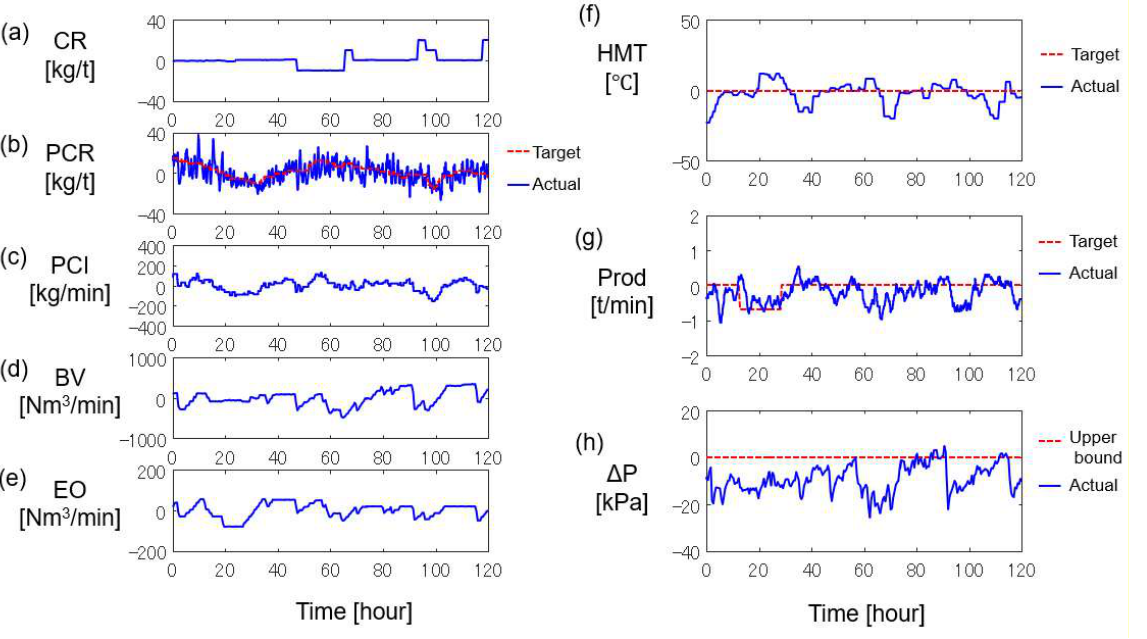
Figure 8. Real operation result by developed control system: ( a ) coke rate, ( b ) pulverized coal rate, ( c ) PC flow rate, ( d ) blast volume, ( e ) enrichment oxygen flow rate, ( f ) hot metal temperature, ( g ) production rate, ( h ) pressure drop.